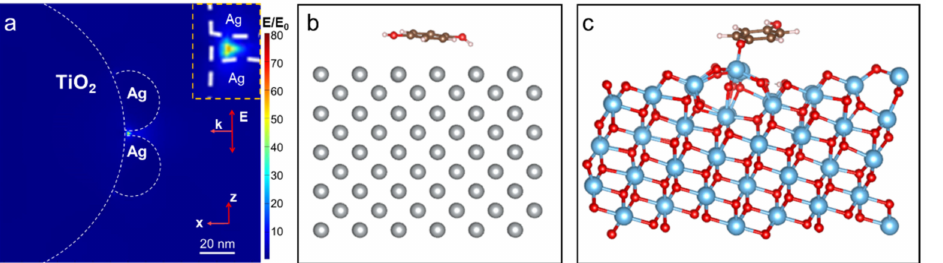
Figure 6. SERS enhancement mechanism of Ag/b-TiO 2 . ( a ) Two adjacent Ag NPs on the surface of b-TiO 2 are simulated by FDTD. The illustration is an enlarged image. ( b ) Density functional theory simulation of a hydroquinone molecule adsorbed on the surface of Ag. ( c ) Density functional theory simulation of a hydroquinone molecule adsorbed on the surface of TiO 2